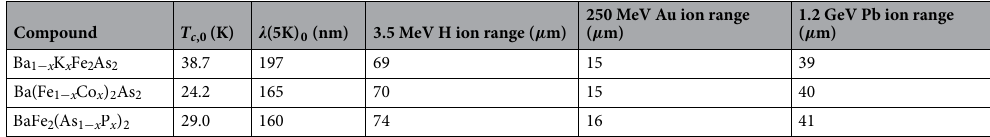
Table 2. Critical temperature and low-temperature London penetration depth for the as-grown crystals, implantation depth (ion range) for each employed energy and ion combinations.